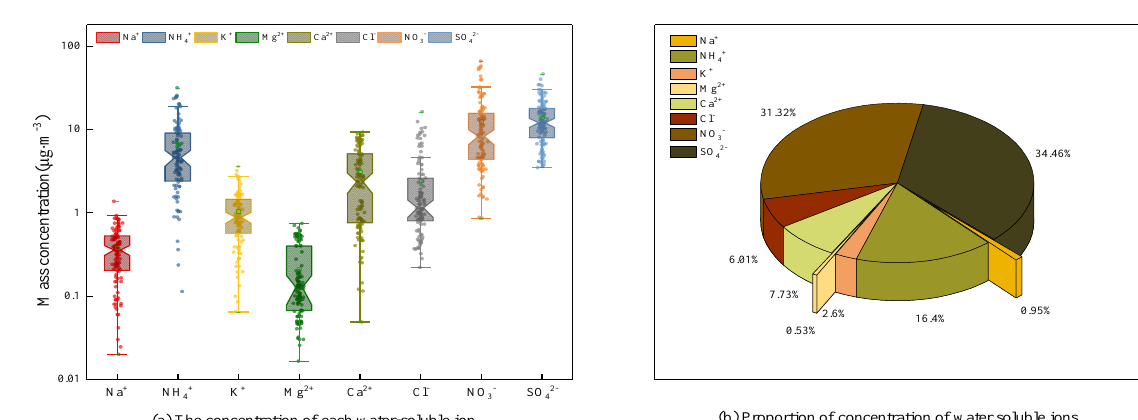
Figure 4. Concentration and proportion of some water-soluble ions in PM 2.5 . Na + , sodium ion; NH 4+ , ammonium ion; K + , potassium ion; Mg 2+ , magnesium ion; Ca 2+ , calcium ion; Cl − , chloride ion; NO 3 − , nitrate; SO 42 − , sulfate.